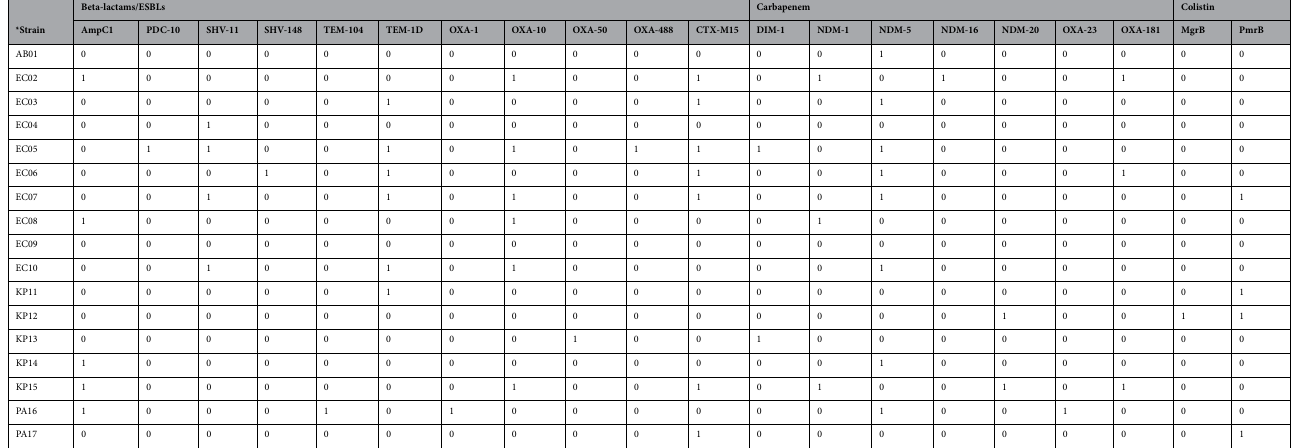
Table 3. Genotype profiling of 17 beta-lactam/carbapenem-resistant Gram-negative bacteria (CR-GNB). * AB Acinetobacter baumannii, EC Escherichia coli, PA Pseudomonas aeruginosa, KP Klebsiella pneumonia, 1: present, 0: absent.